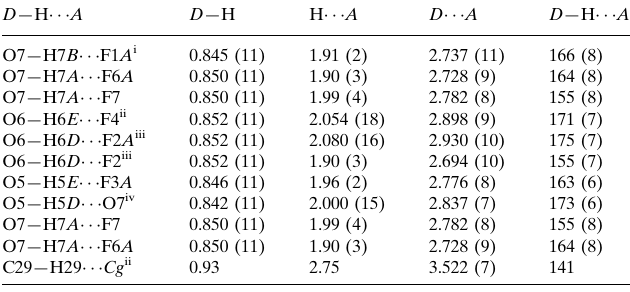
Hydrogen-bond geometry (A˚ , (cid:3)